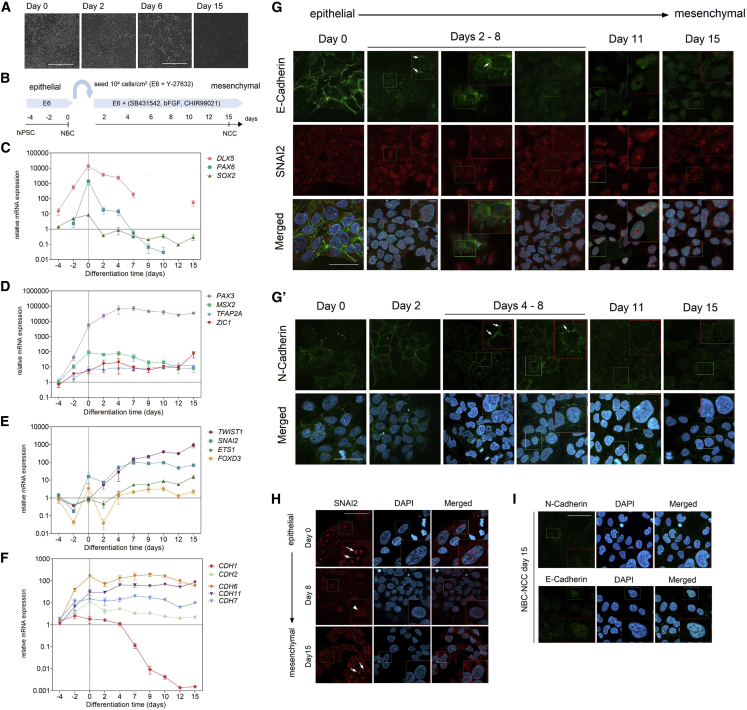
NBC-to-NCC Differentiation Recapitulates NC Specification and EMT(A) Representative phase-contrast micrographs depicting epithelial-to-mesenchymal morphological changes during NBC-to-NCC differentiation. Scale bars, 400 μm.(B) Schematic representation of the differentiation setup encompassing hiPSC-to-NBC followed by NBC-to-NCC derivation.(C–F) Time series qRT-PCR analysis of (C) NPB factors PAX6, SOX2, and DLX5, (D) NPB/NC specifiers PAX3, MSX2, TFAP2A, and ZIC1, (E) NC specifiers/EMT inducers TWIST1, SNAI2, ETS1, and FOXD3, and (F) cadherins involved in NC specification/EMT CDH1, CDH2, CDH6, CDH7, and CDH11. Expression values were plotted relative to day −4 except for PAX6 and TFAP2A (day −2). qRT-PCR data are plotted as mean ± SEM (n = 3 biological replicates).(G and G′) Time series immunofluorescence analysis showing expression patterns for (G) E-cadherin (CDH1) and SNAI2, and for (G′) N-cadherin. Arrows indicate E/N-cadherin expression at cell-cell junctions. Panels for F8799-1c1 are shown here as representative and in Figures S2 and S3 (n = 3 biological replicates).(H) Representative immunofluorescence showing SNAI2 expression patterns observed in: NBCs (day 0), during NBC-NCC induction (observed from days 2 to 8), and in NBC-NCCs (day 15). n = 3 biological replicates.(I) Representative immunostaining showing mesenchymal expression patterns for E-cadherin and N-cadherin in NBC-NCCs on day 15 (n = 3 biological replicates).For (G)–(I) Scale bars, 45 μm. Insets: 2× magnification. Related to Figures S2 and S3.